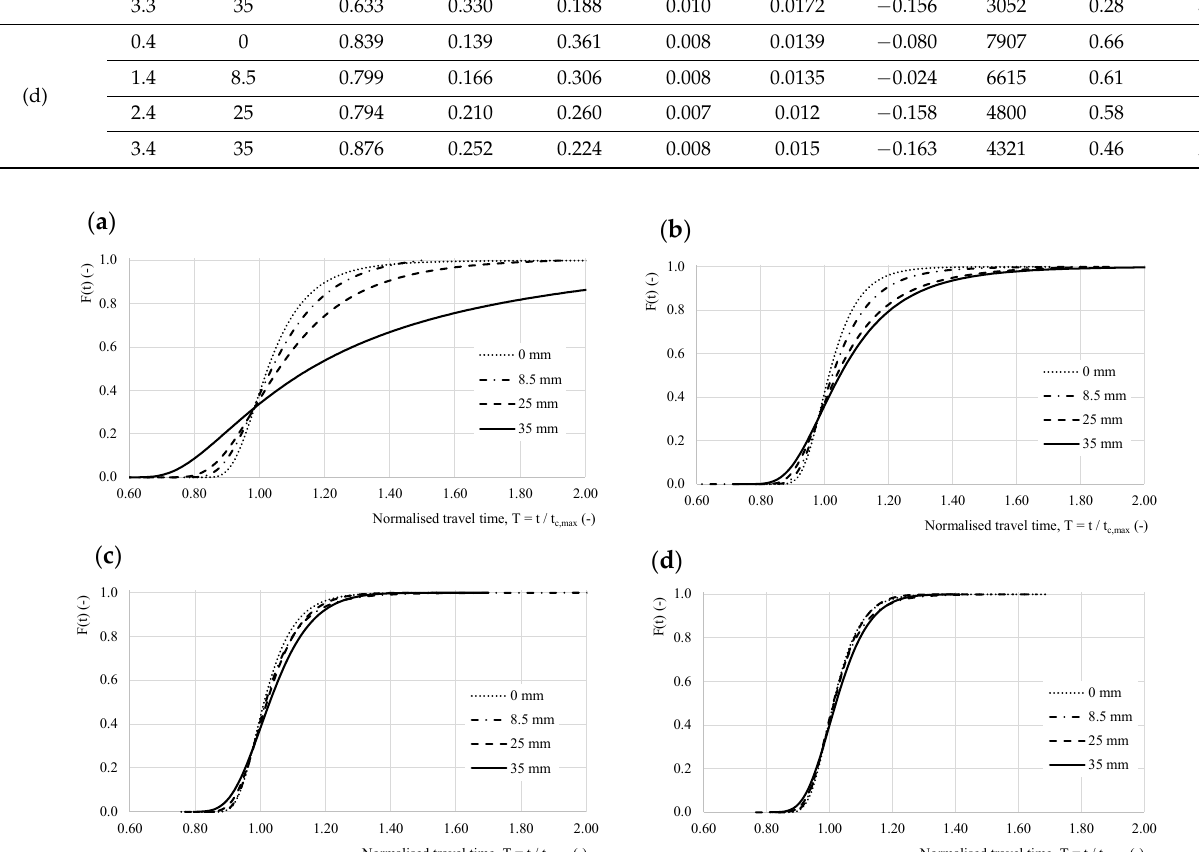
Figure 8. Results of tracer experiments—normalised cumulative residence time distribution (CRTD). The particular image tagging ( a – d ) corresponds with the experiment groups in Table 2. Table 2. Experiment groups.